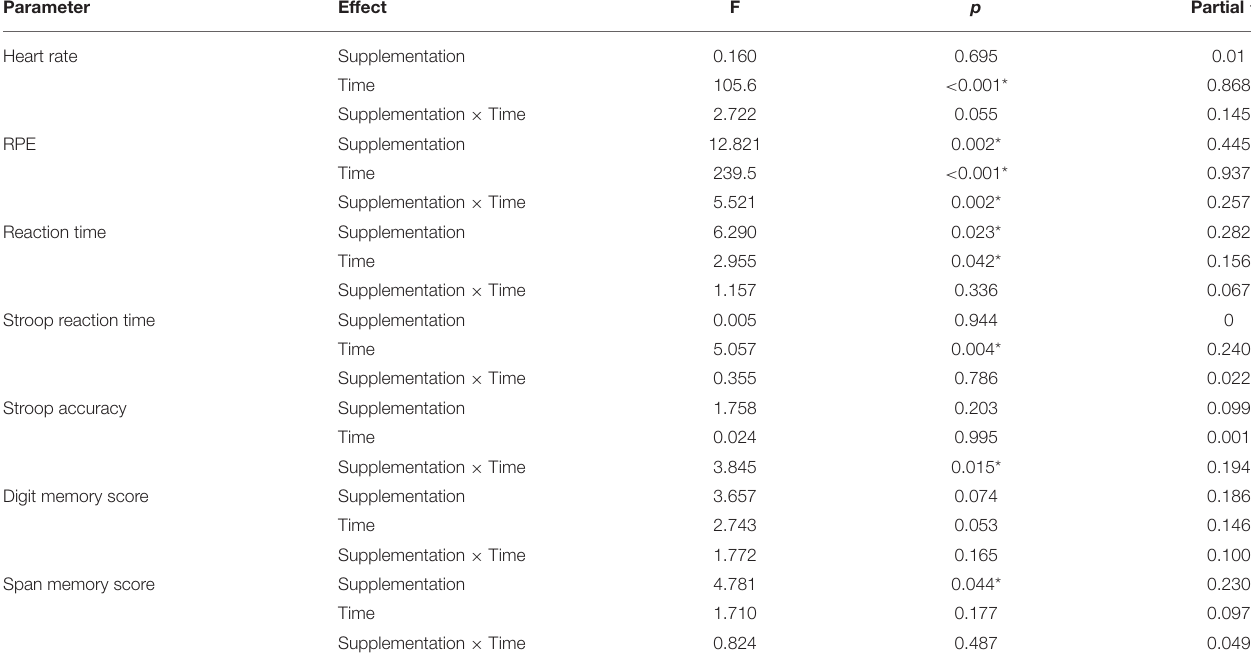
TABLE 2 | Results from the two-way ANOVA during the two experimental sessions.